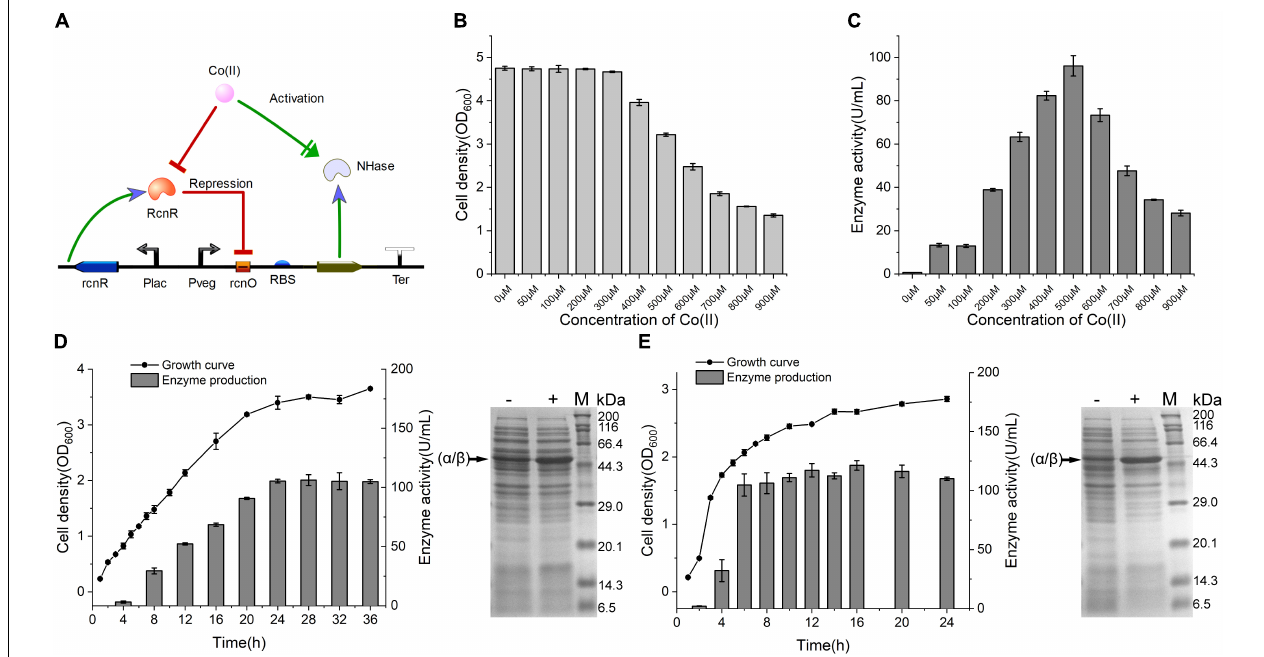
FIGURE 4 | NHase production by CIES. (A) Schematic diagram of NHase production by CIES, in which Co(II) functioned as both inducer of expression and metal ligand of activated NHase. (B) The influence of concentration of Co(II) for NHase production on cell growth. (C) Determination of optimized concentration of Co(II) for NHase production. (D) Determination of growth curve and enzyme expression profile of NHase production by CIES over the fermentation process. (E) Determination of growth curve and enzyme expression profile of NHase production by IPTG-induced pET expression system over the fermentation process. -: no Co(II) added; +: added Co(II) with 500 µ M of final concentration. The band of fused α / β subunit was indicated by an arrow. All error bars in figures presented root-mean-square deviation of three separate